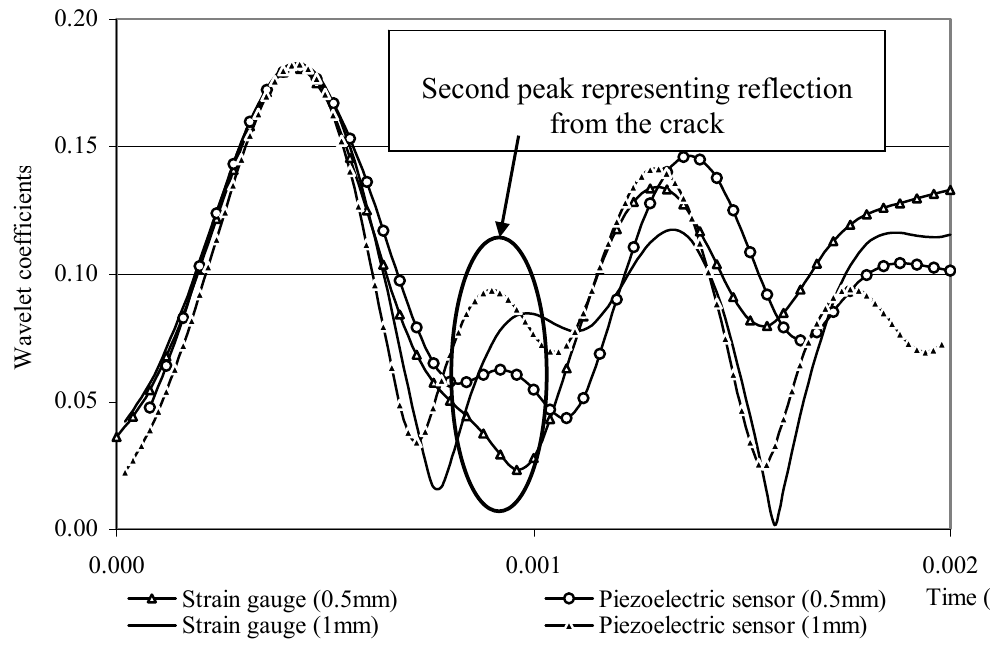
Figure 4. Wavelet coefficients at scale 12 of signals from piezoelectric sensor and strain gauge for 0.5 mm and 1 mm deep cracks (adopted from Figure 4 in